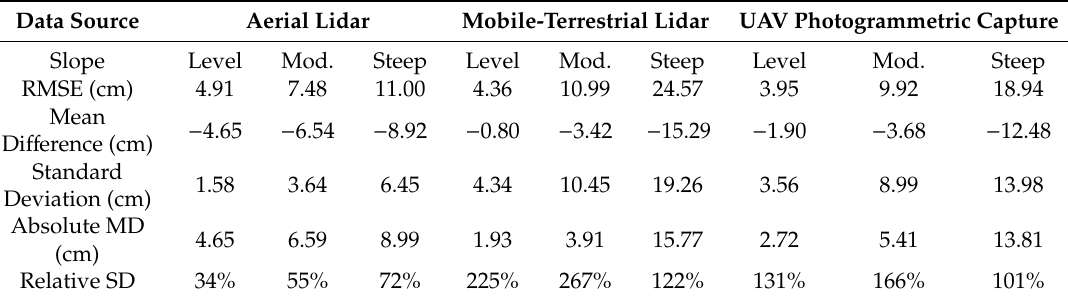
Table 5. Statistics Related to Di ff erence in Elevations for Three Slope